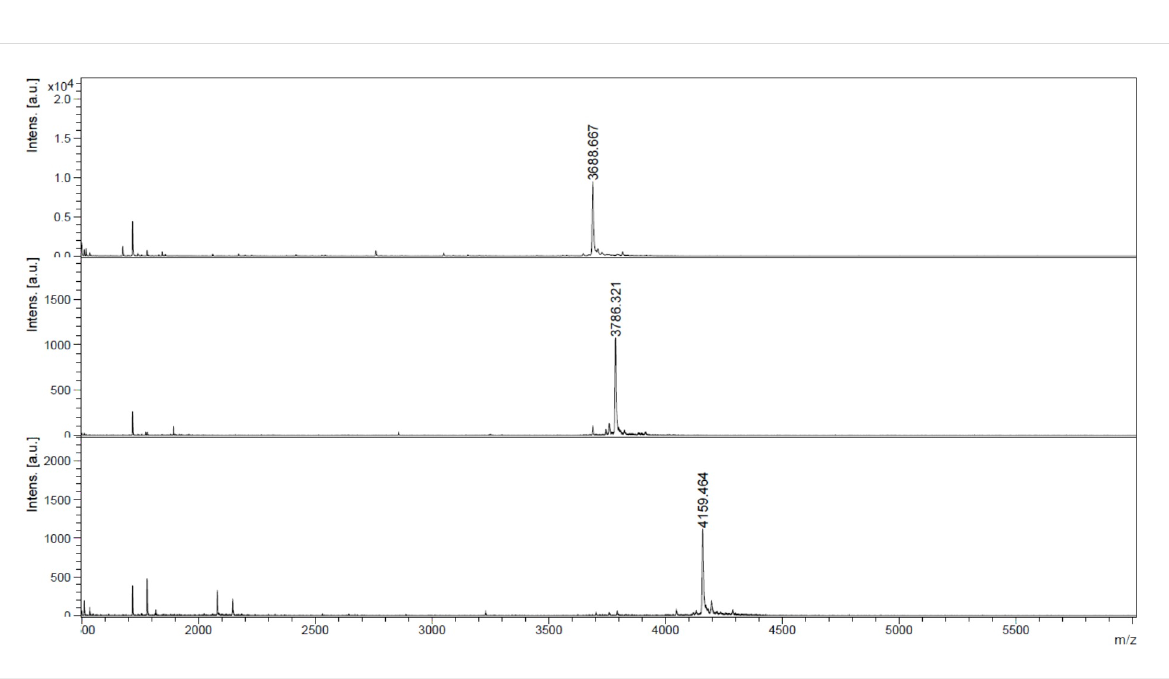
emission at 656 nm, respectively (Figure 2b). The solva- tochromic property of the Nile red-labeled acpcPNA is demon- strated as shown by the progressively blue-shifted